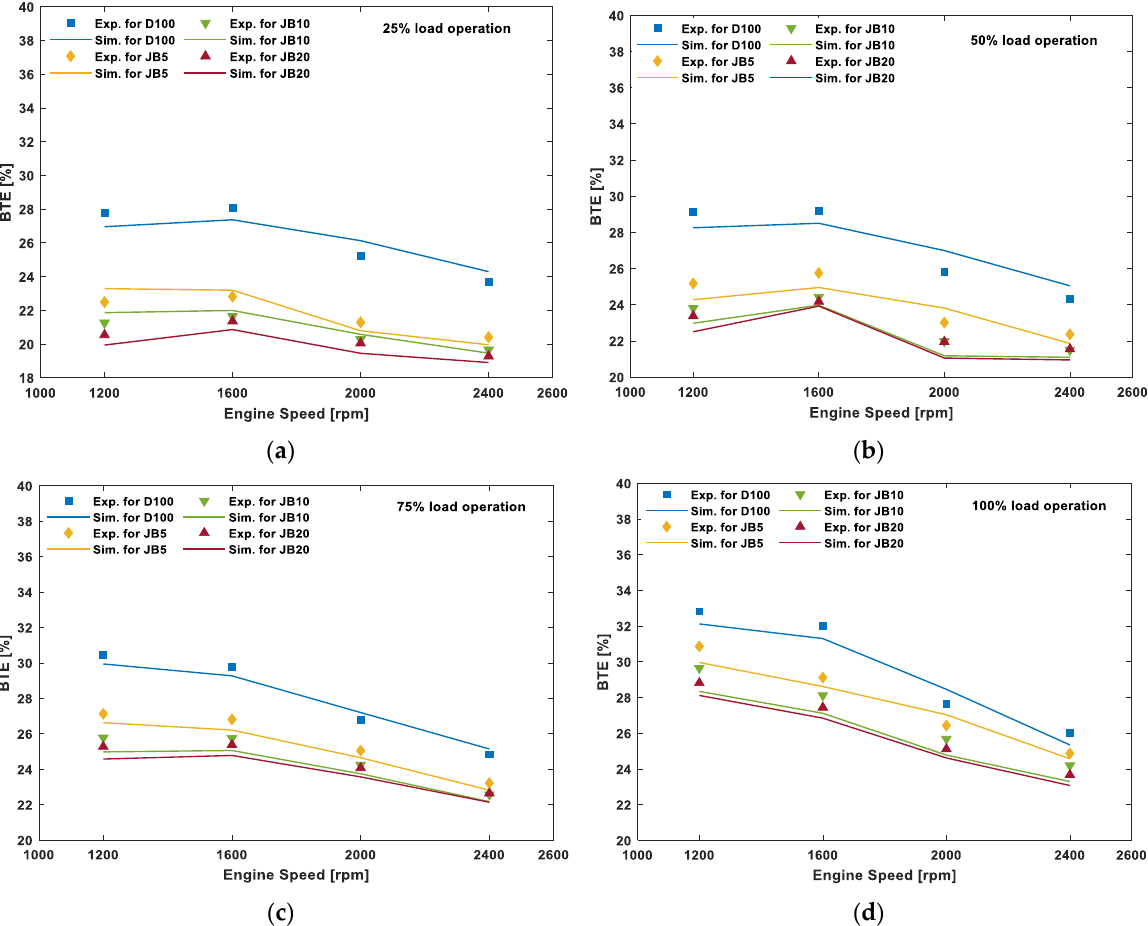
Figure 5. Comparison between simulation and experimental results of BTE for diesel and JB blends at ( a ) 25%, ( b ) 50%, ( c ) 75% and ( d ) 100% loading conditions.